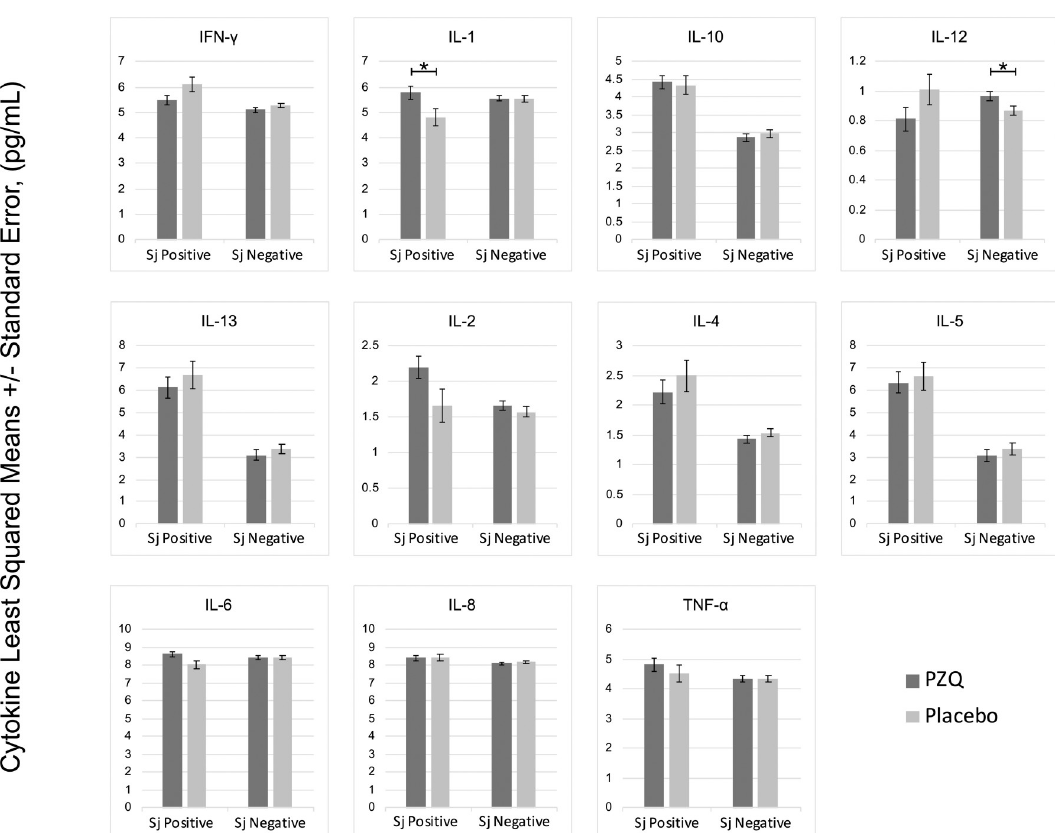
Fig 3. PZQ in utero priming: cytokines stimulated with Soluble Egg Antigen, N = 295. Values are natural log-transformed. Each model adjusted for the antigen stimulation negative control. Asterisks represent significant differences determined by multivariate